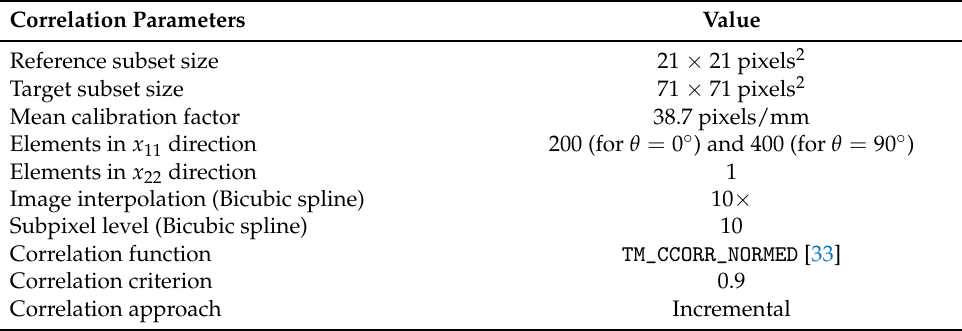
Table 1. iCorrVision-2D DIC